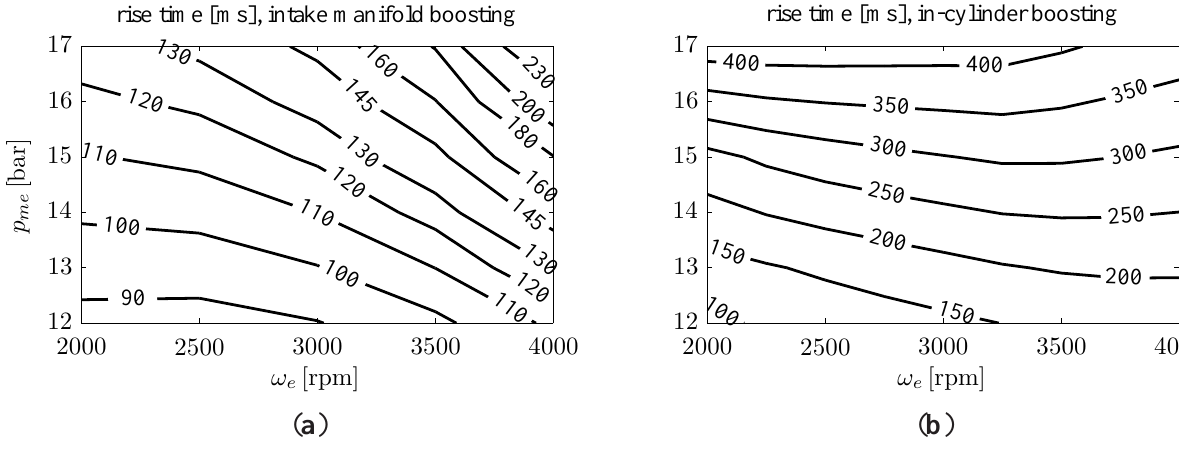
. ( a ) With intake e